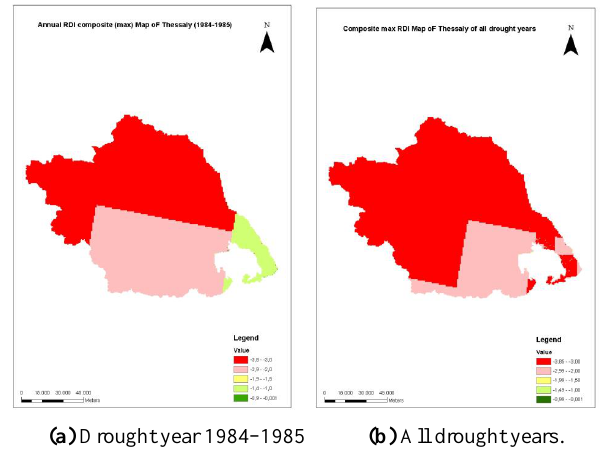
Fig. 6. Annual remotely sensed RDI composite (max) map of Thes- Figure 6. Annual Remotely Sensed RDI composite (max) map of Thessaly. 40